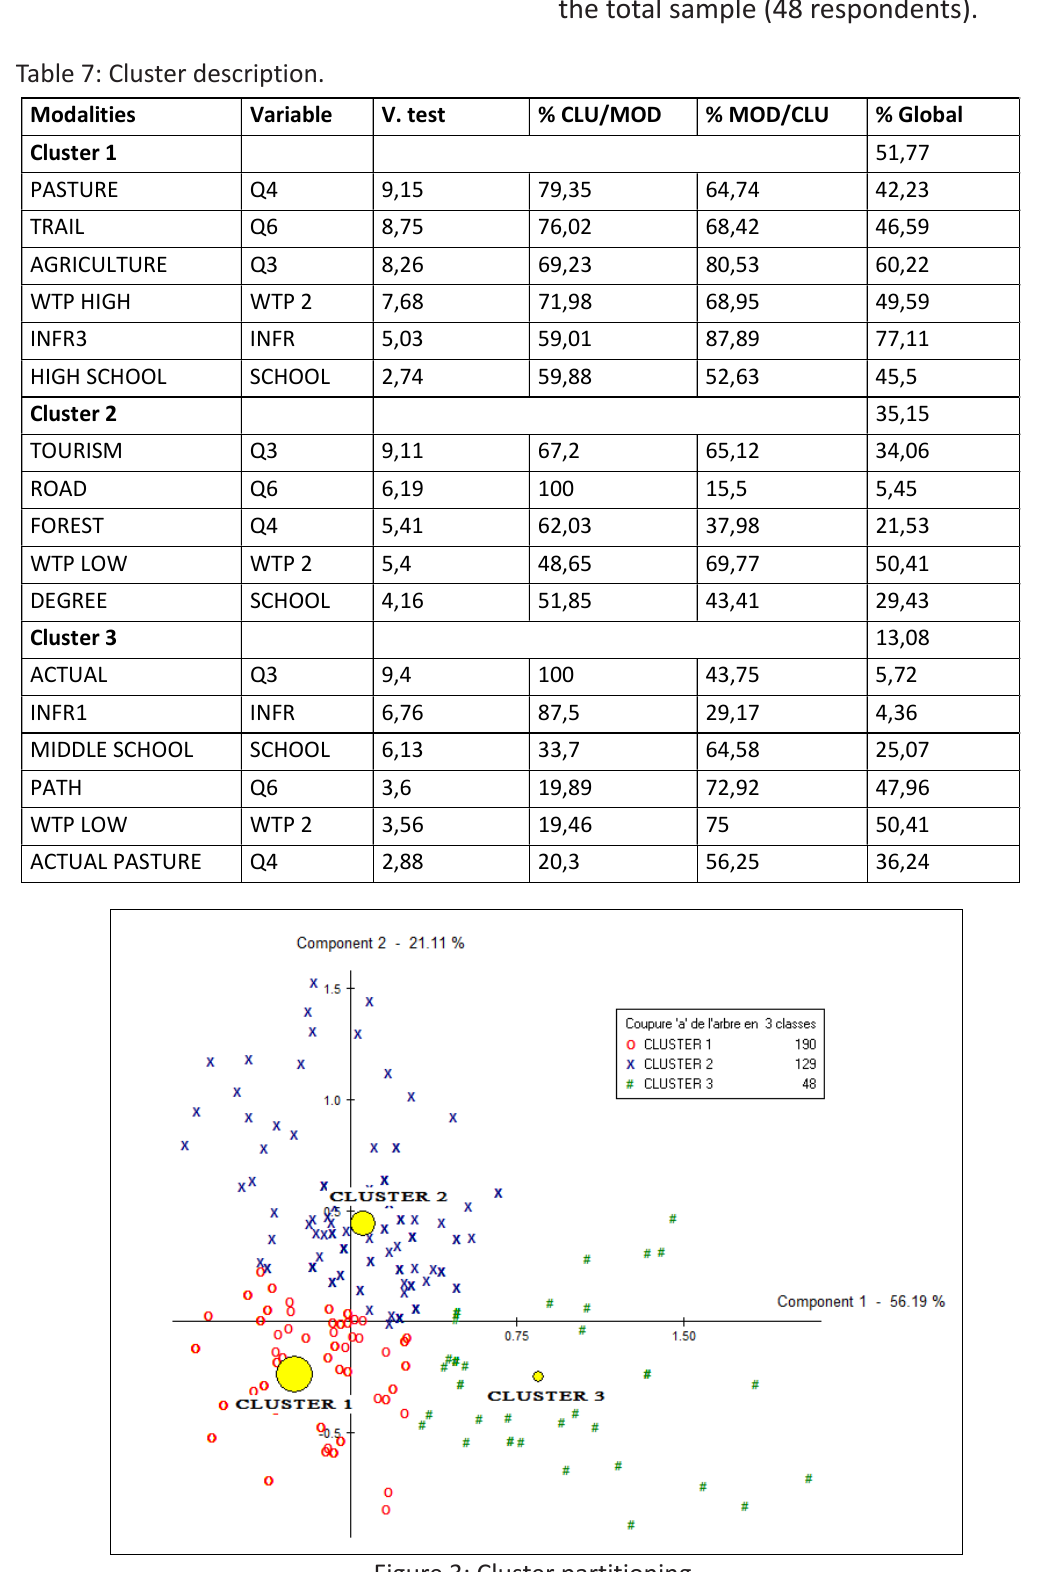
Figure 3: Cluster partitioning